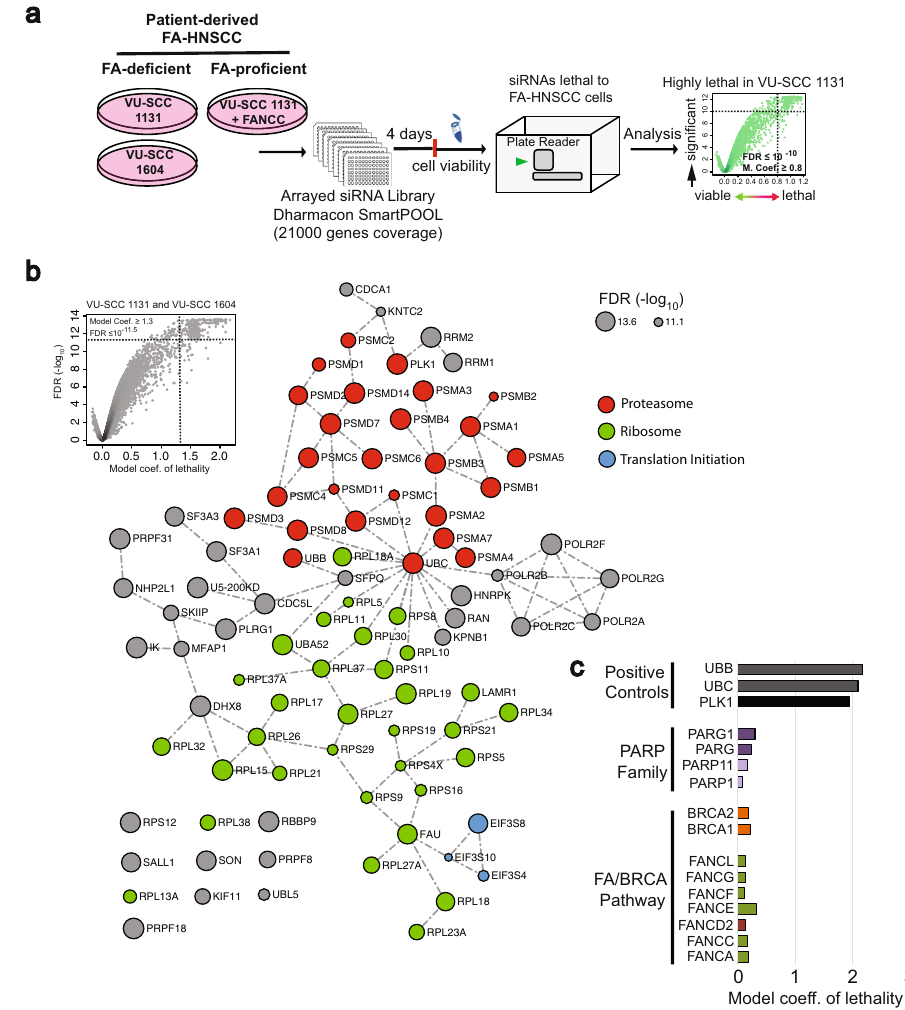
Fig. 1 Genome-wide synthetic lethality screens in Fanconi anaemia head and neck squamous-cell carcinoma. a Design and format of genome-wide siRNA screens performed in patient-derived FA-HNSCC cell lines VU-SCC 1131 (VU1131) from complementation groups FA-C and VU-SCC 1604 (VU1604) from complementation group FA-L along with a phenotype-corrected (wild-type FANCC complemented) cell line VU-SCC 1131 + FANCC (VU1131 + FANCC) as a reference to delineate genetic-interaction networks synthetic lethal with the loss of FA pathway. Screens were performed by reverse transfecting cells in 384-well plates previously arrayed with siRNA library (25 nM each, Dharmacon siARRAY Whole Human Genome) and cell viability was assessed using the CellTiter-Blue ® assay 4 days after gene silencing. Fluorescence signals measured at 570 nm were log-2 transformed and normalised using the RSCREENORM approach (see ref. 24, main text) and lethality scores were calculated per gene, for analysis. All screens were performed in triplicates. Volcano plots depict model coef fi cient of lethality (X-Axis) = statistically derived relative lethality score, values approaching or above 1.0 = highly lethal, and false discovery rate FDR (Y-Axis) = statistical signi fi cance. All screens were performed in triplicate. b Gene essentiality, interaction network and pathway analysis of combined lethal vulnerabilities identi fi ed in relation to the non-targeting siRNA and positive controls, in FA-C and FA-L HNSCC cell lines VU-SCC 1131 and VU-SCC 1604. Genetic interactions are mined from the GeneMania database and pathway predictions are generated using Reactome. Nodes and edges represent gene names and known physical interactions, respectively. Node sizes are scaled to − log10 FDR values. Node colours depict pathway associations. Note that the red nodes imply the involvement of the protein degradation machinery at large, and are not necessarily limited to APC/C-mediated protein degradation in mitosis. Also, see Supplementary Fig. 1 for lethal interaction networks in individual FA- HNSCC complementation group cell lines. c Performance of a selection of genes of the FA-BRCA pathway (FA genes — A, C, D2, E, F, G and L, BRCA1, BRCA2) along with positive controls PLK1, UBB and UBC, as an indication of biological effect size upon silencing. Genes are ranked based on the model coef fi cient of lethality upon silencing as well as FDR. Hits with a calculated model lethality coef fi cient ≥ 1.0 were considered to have a strong lethal effect. For comparison, straight-lethal positive control siRNAs PLK1, UBB and UBC are plotted alongside (lethality coef fi cient ca. 2). Bars represent an average of 9 values per gene. Note that, as expected, silencing of additional FA or BRCA genes did not result in signi fi cant lethality in these FA-HNSCC lines, while the PARP family genes — well-documented to be synthetic lethal with BRCA loss — did not result in lethality